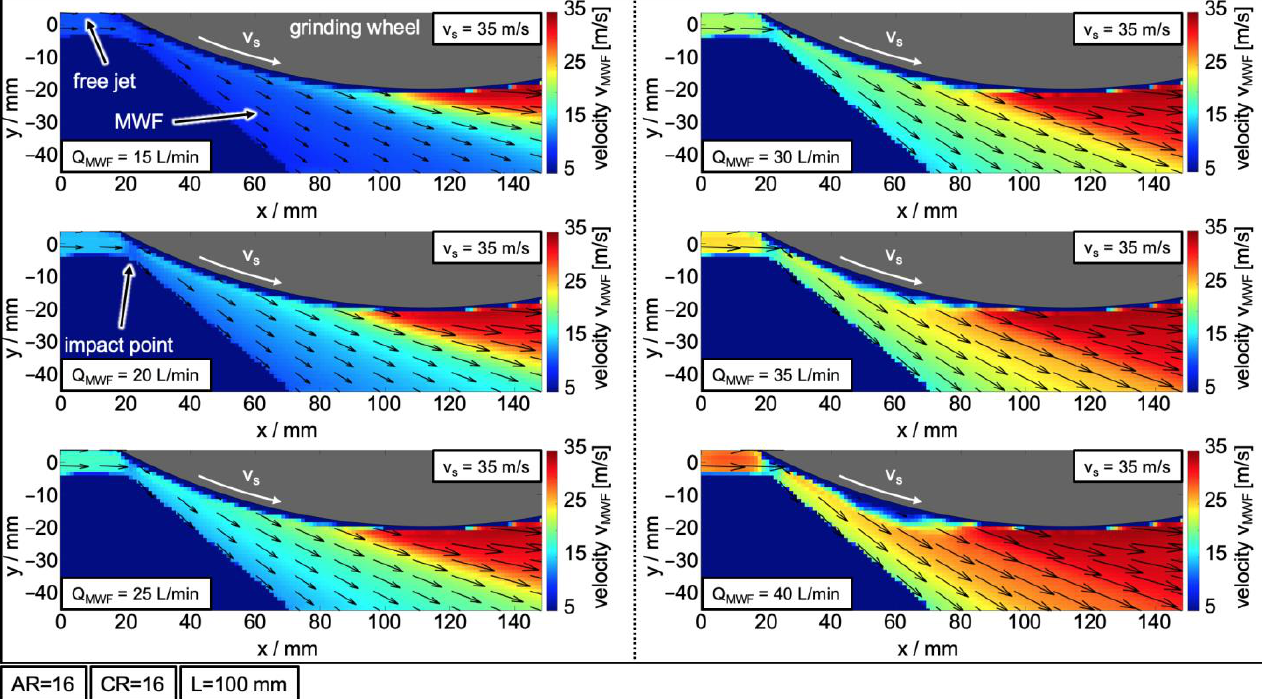
Figure 13. Velocity field in the interaction area under different flow